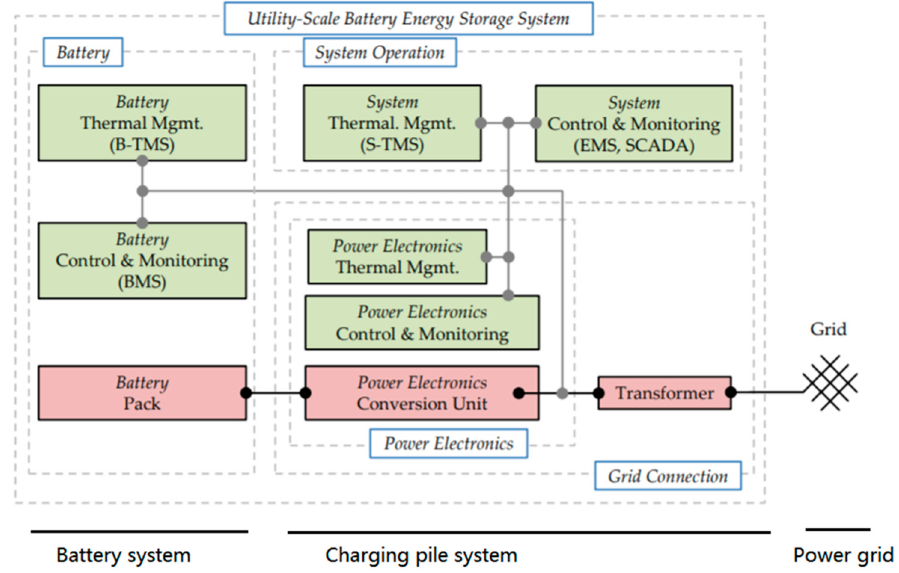
Figure 1. Overview to functional blocks of a utility-scale battery storage system [4].